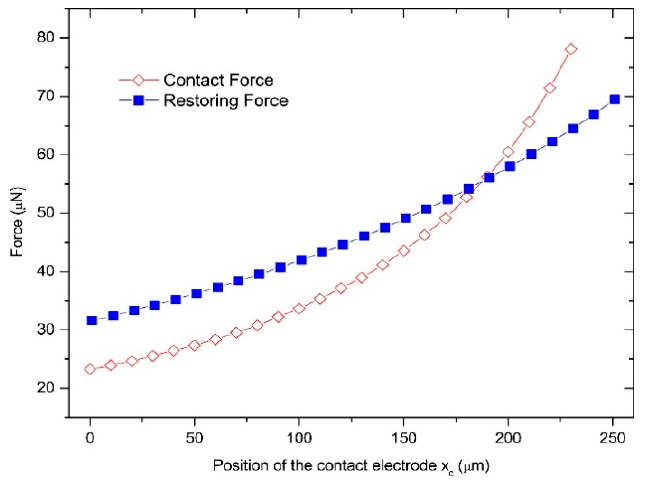
Figure 4. Simulated contact force and restoring force against x c .